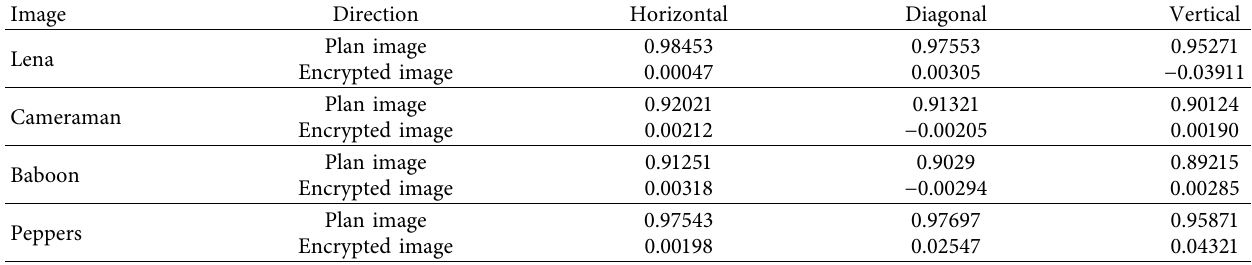
Table 5: Correlation coefficient of the original images and their encrypted images using the proposed chaotic maps.